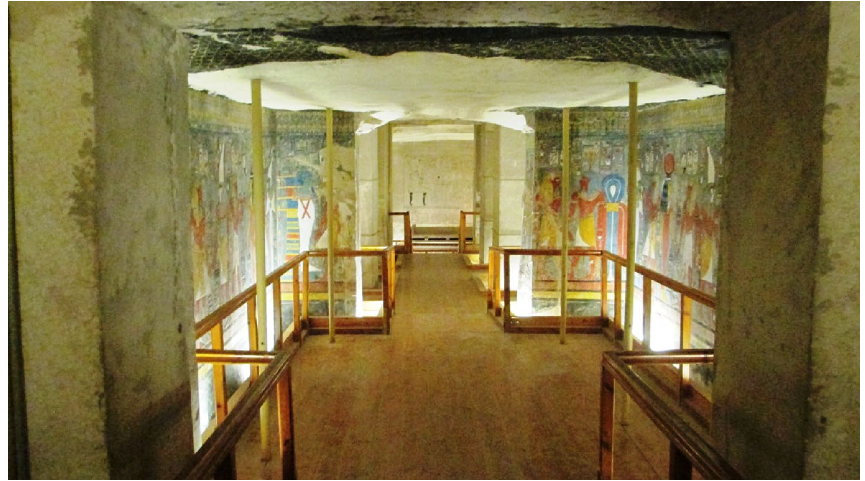
Fig. 1 In-plane deformation patterns of the ceiling and walls like vertical cracks and crown zone rock falling and intensive cracking due to over loading (geostatic loading) and impact of old and modern flash floods